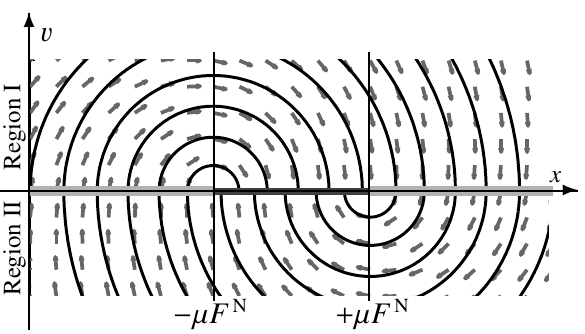
Figure 2. Dynamical system of the di ↵ erential equation (8), with case 1 indicated by the light gray region on the left, case 2 by the light gray region on the right and case 3 by the black